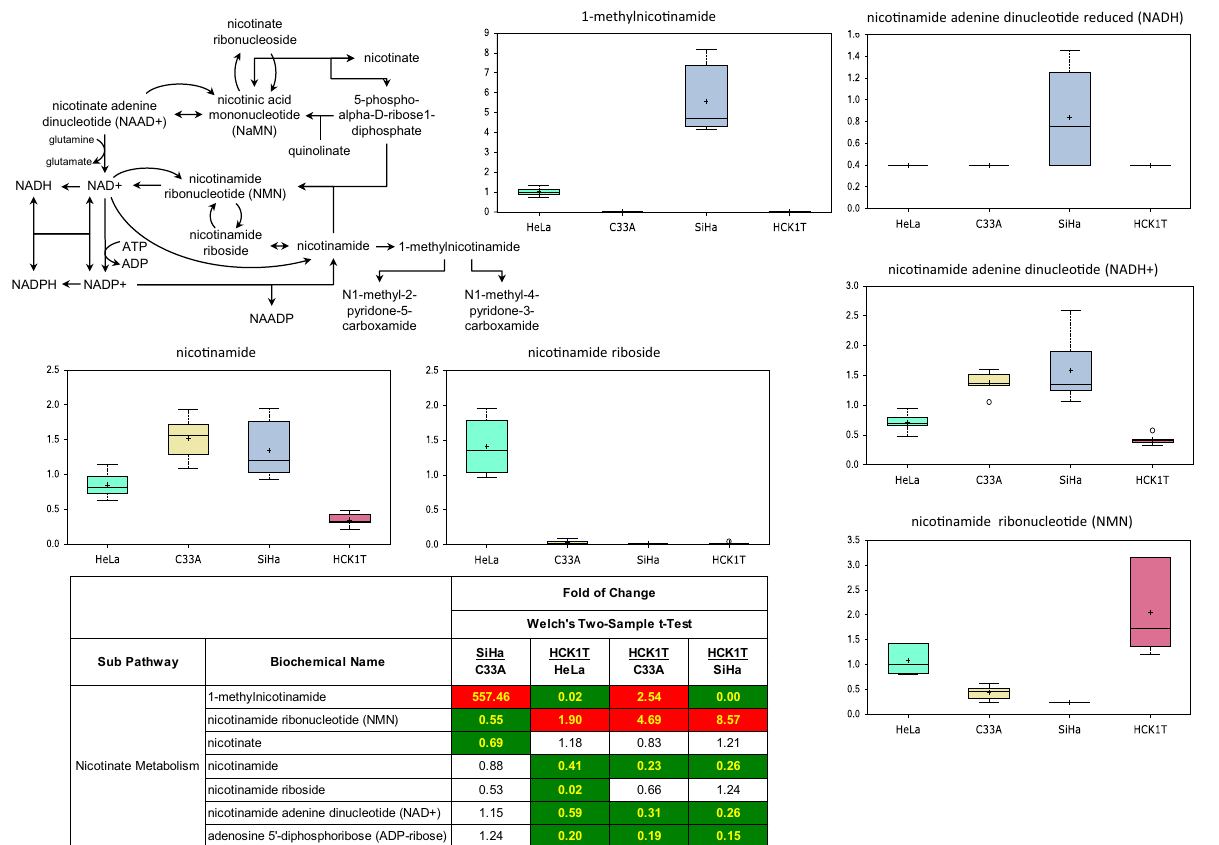
Figure 4. Metabolomic analysis of the differential nicotinate metabolism of the four cervical cell lines. Biochemicals displaying salient changes among the four cell types are shown as box plots. Each box plot provides a measure of scaled intensity, normalised by protein content. The nicotinate pathway map and a representative heat map, with the major biochemical changes is also shown. For the color key of the heat map, see the legend of Fig.